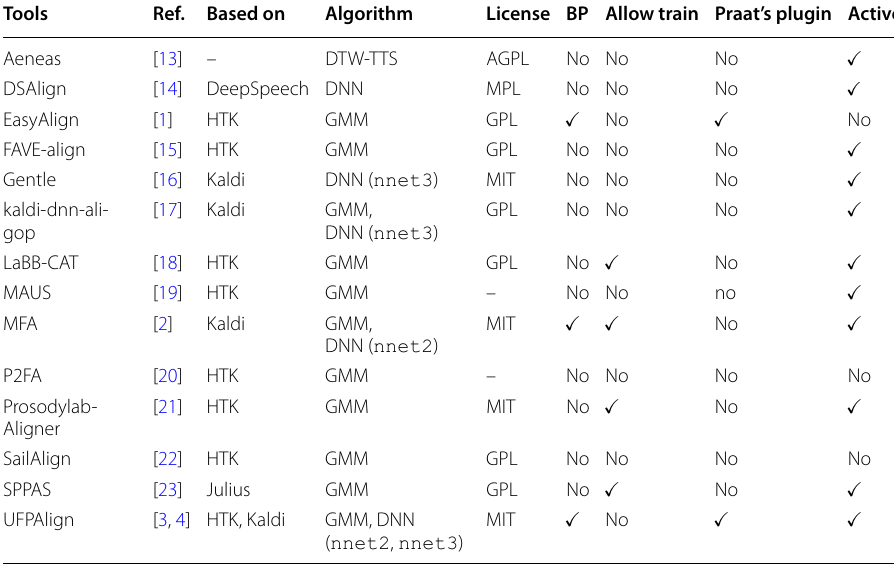
Characteristics like the ASR framework the system is built upon, main algorithms used, license, and whether it supports Brazilian Portuguese (BP), training models over the same dataset to be aligned, and interfacing with Praat’s GUI are also discriminated. The last column also indicates whether the aligner was found to be still actively maintained